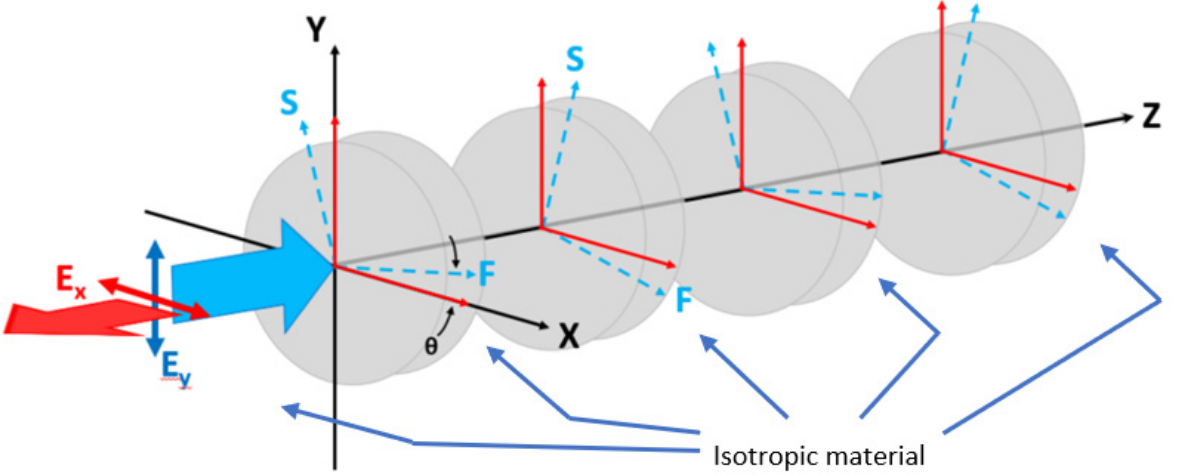
Figure 3. A stack of alternating birefringent waveplates. The material between the waveplates is isotropic.